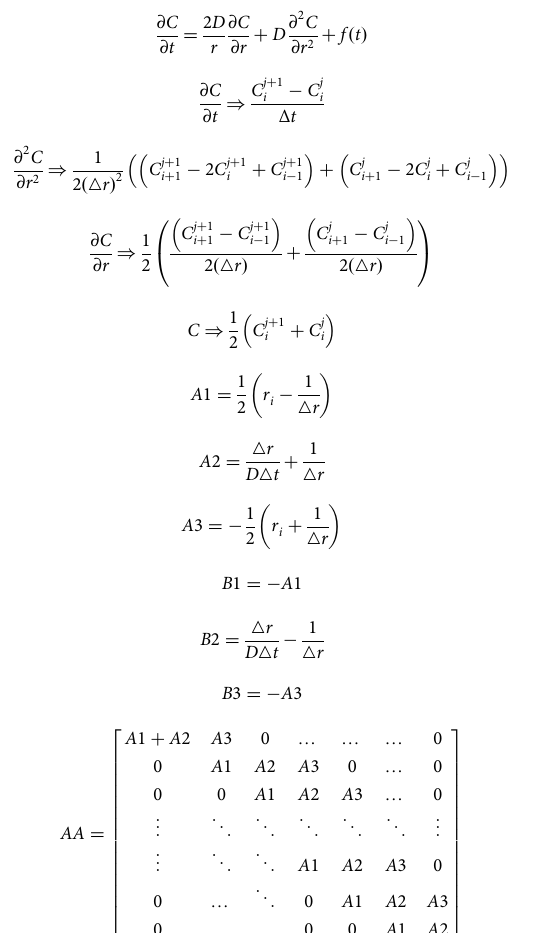
Data availability Sample metadata have been archived in the System for Earth Sample Registration (SESAR) with associated International GeoSample Numbers (IGSNs). The new data (Supplementary Data 1, https://doi.org/10.26022/IEDA/111776) as well as the compiled xenolith data set used here (Supplementary Data 2, https://doi.org/10.26022/IEDA/ 111777) have been submitted to EarthChem (www.earthchem.org/petdb), and are provided as Supplementary data sets linked to this